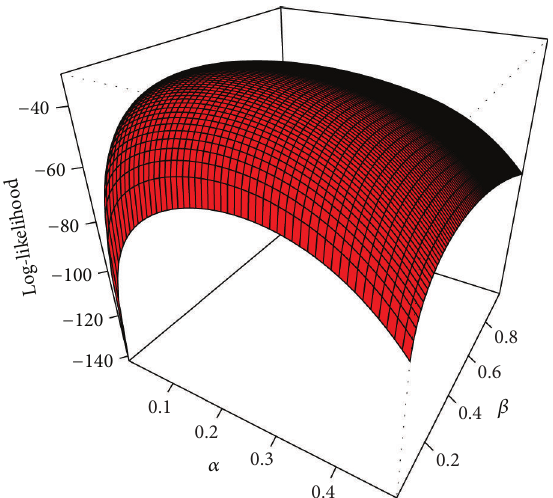
Figure 1: Likelihood profile with respect to parameters for real data